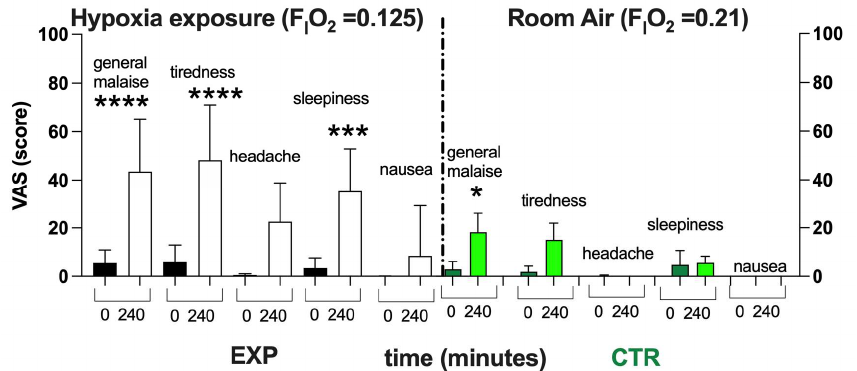
Figure 3. Histogram plot (mean ± SD) of the VAS score from the EXP and CTR. Data obtained Pre- (black and green bars respectively) and after 240 min of NH (white and light green bars, respectively) are shown. Changes over time were significantly different when compared to pre-exposure levels (* p < 0.05; *** p < 0.001; **** p < 0.0001 symbols).